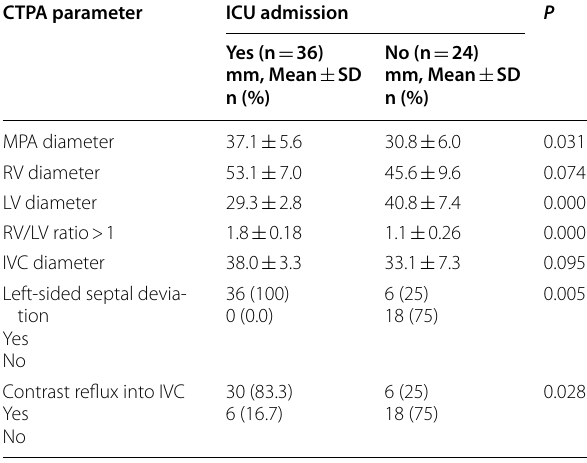
Table 2 Comparison between CT findings in patients who